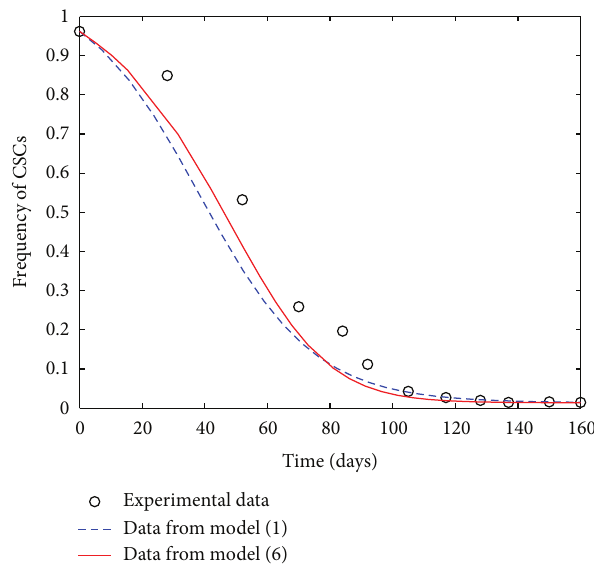
Figure 3: Simulations of the dynamical behaviors of the frequency of CSCs. Experimental data are represented by open circles. The blue dashed line denotes the best fit of model (1), and the red solid line denotes the best fit of model